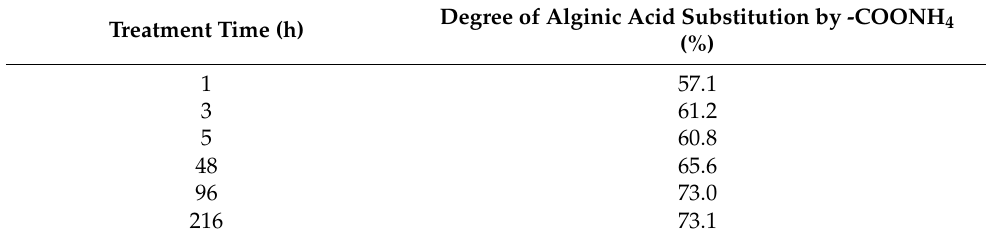
Table 2. Degree of alginic acid substitution by ammonium groups.